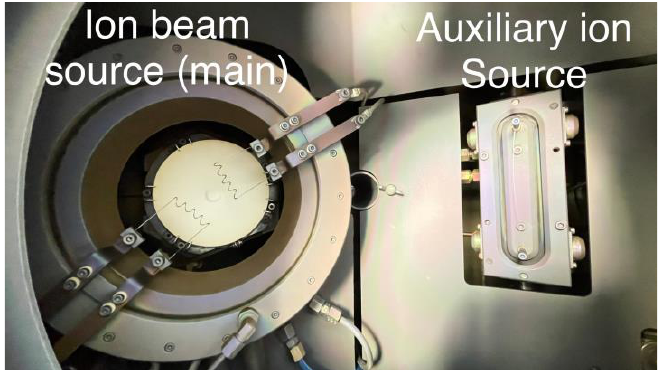
Figure 3. The image of an annular ion source ( left ) and auxiliary ion source ( right ).